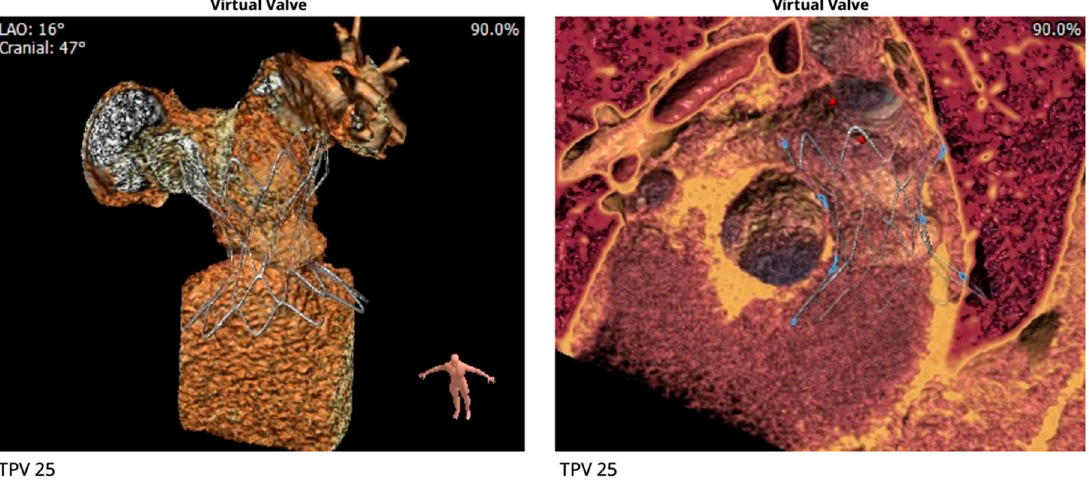
Figure 12. Pre-procedural virtual modeling demonstrates ideal placement of the Harmony valve.